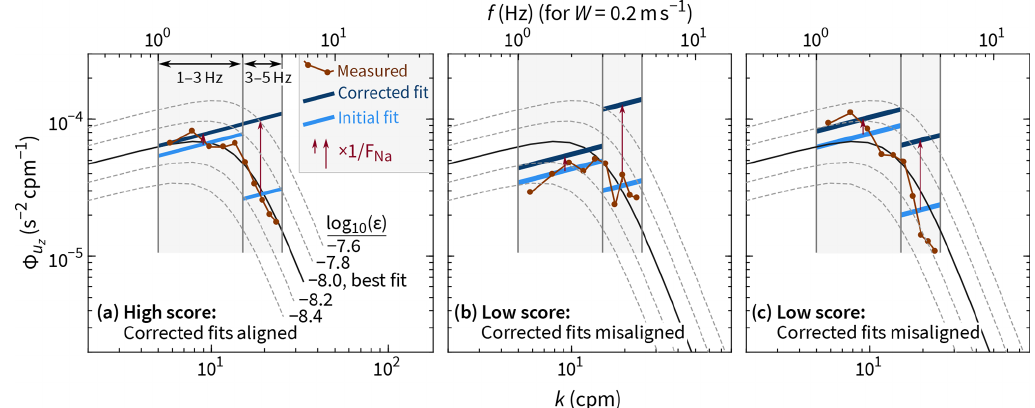
Figure 3. A visual demonstration of how the (cid:15) fit score (Eq. 26) characterizes better and worse fits. For all three of these hypothetical spectra, (cid:15) values from the two fits (1–3 and 3–5Hz) average to (cid:15) = 1 . 0 × 10 − 8 Wkg − 1 . Only in panel (a) , however, does the measured spectrum agree well with the Nasmyth spectrum for this (cid:15) value. In practice, the initial fits would be undertaken on voltage spectra; here, we are using